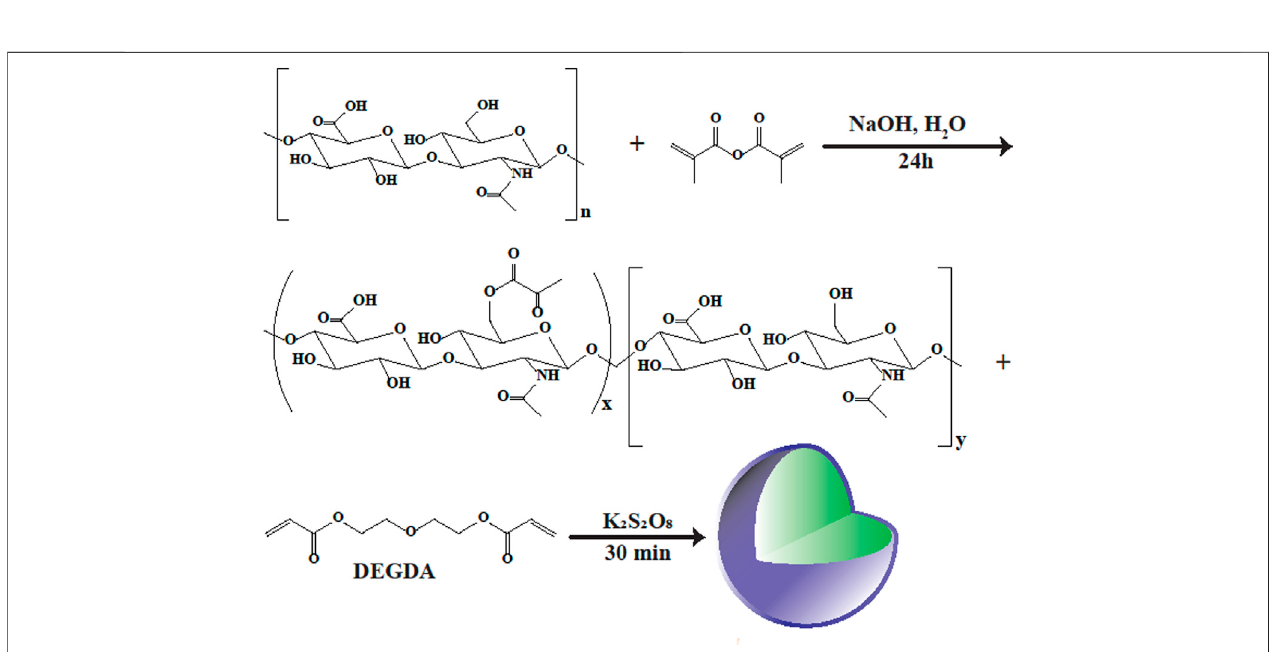
FIGURE5| Synthesis route ofHAnanogels.In ordertopresentvinylgroupsinto HA,thesodium hyaluronic acidwasmodi fi edwith methacrylic anhydride, and the methacrylatedhyaluronicacid(MAHA)wasattained.Then,theHAnanogelswereacquiredbythecopolymerizationofMAHAwiththeesterbondcontainingcross-linker, di(ethylene glycol) diacrylate (DEGDA), in a aqueous solution (Yang et al., 2015).